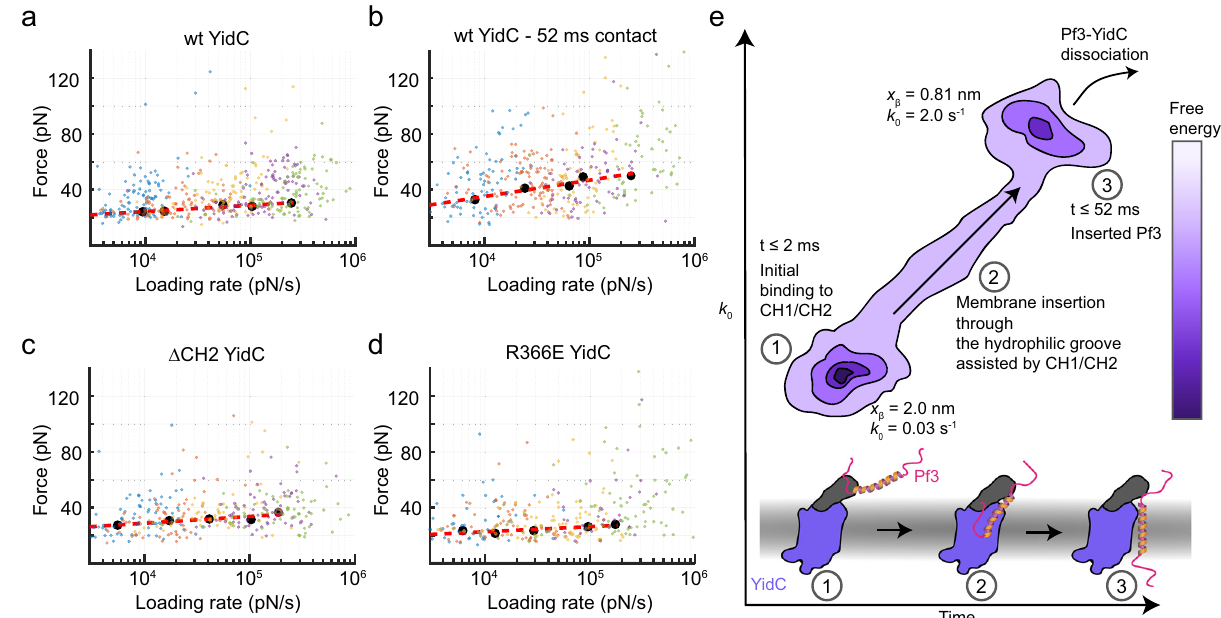
Fig. 5 Free-energy landscape of YidC binding Pf3. a (Un-)binding forces of wt YidC and Pf3 plotted against the loading rate. Data points represent single (un-)binding forces collected with SMFS at 2 ms contact time. b (Un-)binding forces of wt YidC and Pf3 collected at 52 ms contact time. c (Un-)binding forces of Δ CH2 YidC and Pf3 at 2 ms contact times. d (Un-)binding forces of R366E YidC and Pf3 at 2 ms contact time. Small dots represent single (un-) binding forces detected at pulling velocities of 1 µ m s – 1 (blue), 3.1 µ m s – 1 (orange), 6.3 µ m s – 1 (yellow), 12.5 µ m s – 1 (purple), and 25 µ m s – 1 (green). Black larger dots represent most probable (un-)binding forces (Supplementary Fig. 14) and most probable loading rates calculated for each velocity using kernel density estimation. Bins were iteratively fi tted using the Bell-Evans model 33 (dashed line) to estimate free-energy landscape parameters (Table 1). Each experiment was repeated at least fi ve independent times. Total numbers of (un-)binding events in each plot for wt YidC were n events = 460 (2 ms) and n = 372 (52 ms), for R366E YidC n = 311, and for Δ CH2 YidC n = 322. e Schematic free-energy landscape of YidC-mediated Pf3 binding and events events events membrane insertion. The structural model at the bottom summarizes the mechanistic insight revealed in this study. YidC with its cytoplasmic α -helices are colored purple and grey, respectively. Pf3 is colored red and orange. Within 2 ms Pf3 binds to the cytoplasmic YidC surface in diverse conformations (1). Then within 52 ms, Pf3 migrates along multiple pathways (2), which involve the hydrophilic groove of YidC, to reach the membrane-inserted state (3). After these binding and insertion steps, the Pf3 polypeptide can dissociate from YidC. Source data are provided as a Source Data fi le. Table 1 Thermodynamic and kinetic parameters describing the binding established between wt, Δ CH2 or R366E YidC and Pf3.